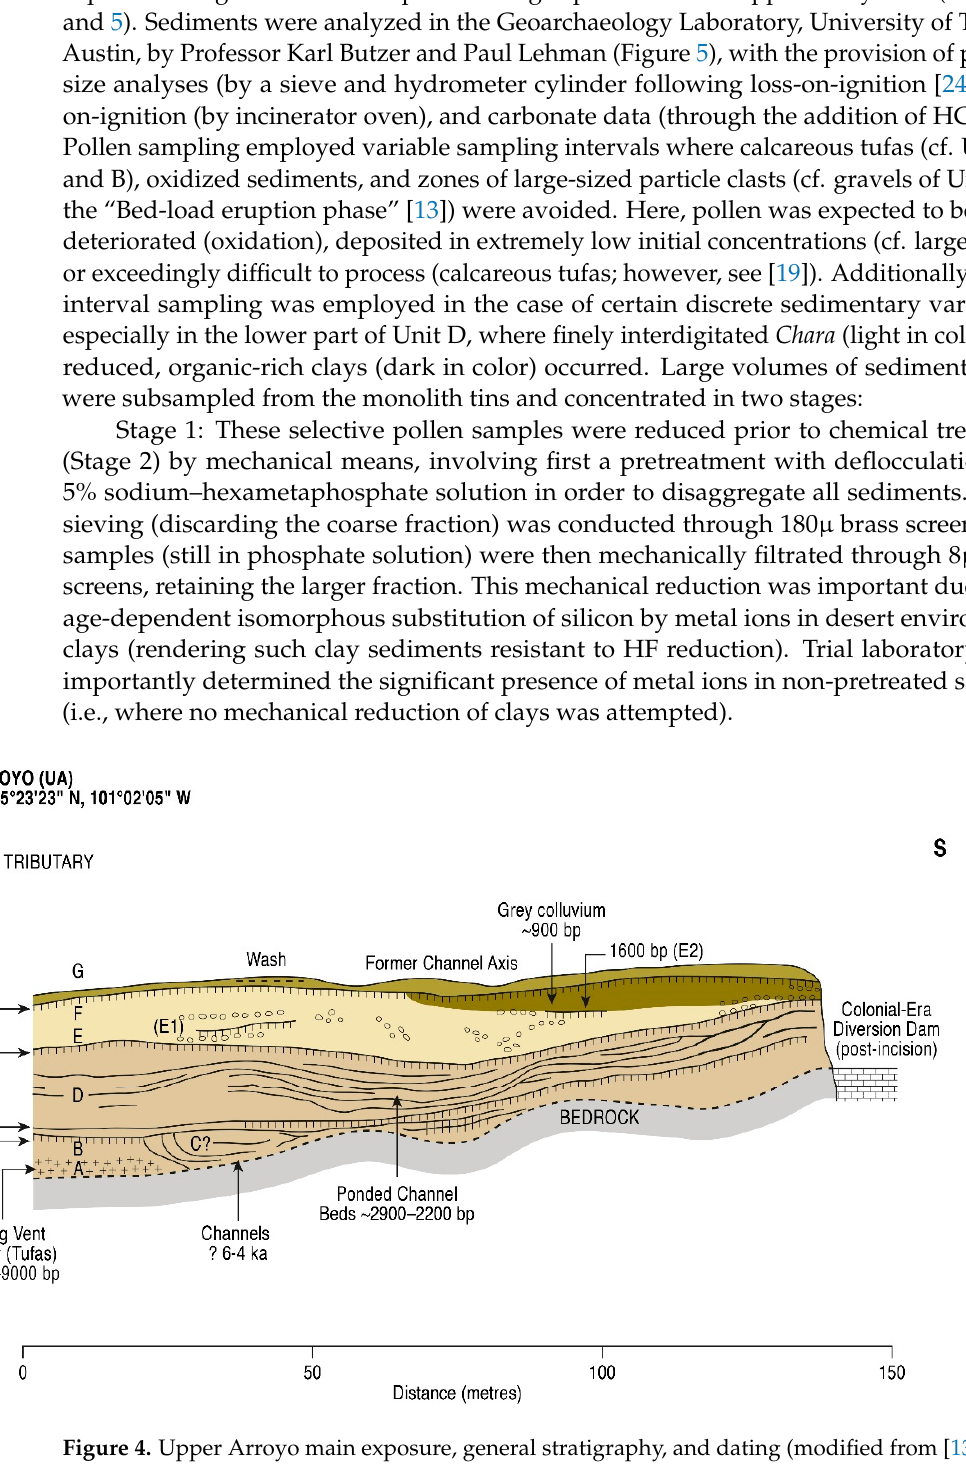
Figure 4. Upper Arroyo main exposure, general stratigraphy, and dating (modified from [13]).